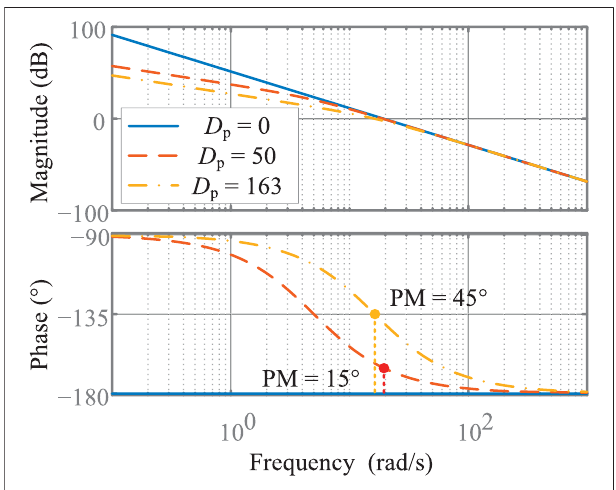
FIGURE 4 | Bode diagrams of G p_open ( s ) with droop control.